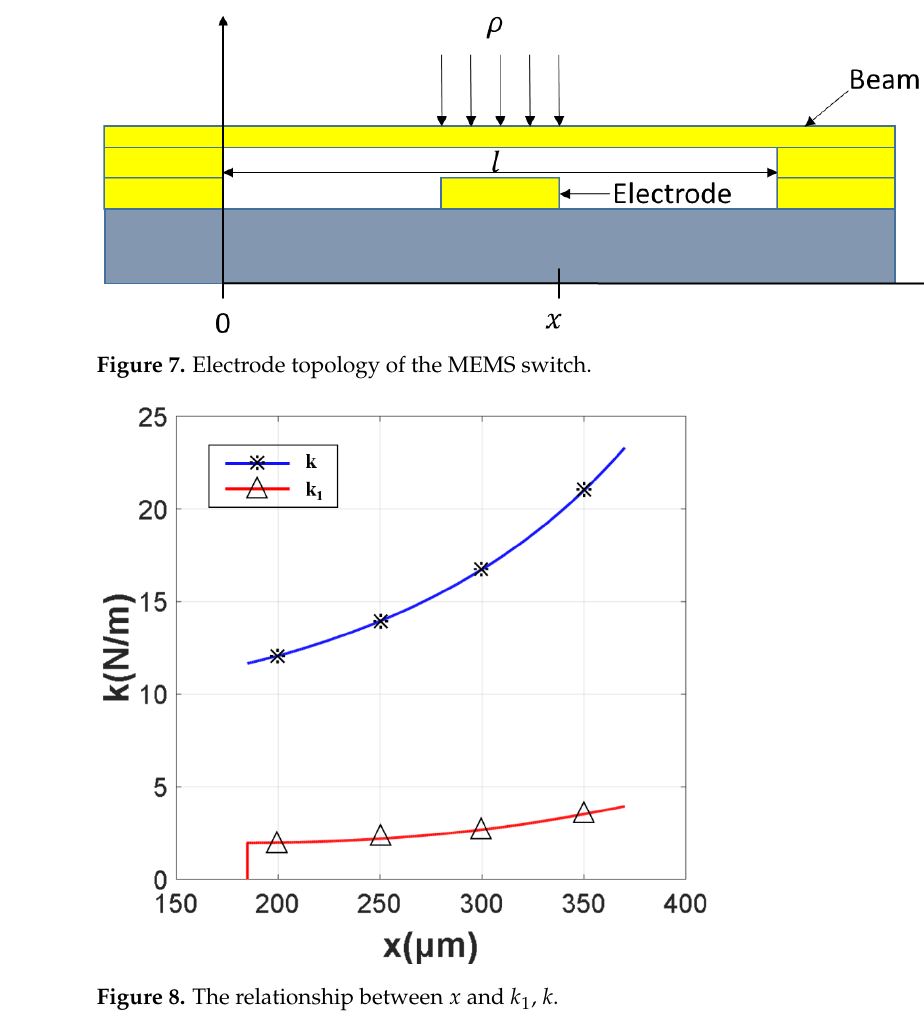
Figure 6. The relationship between the parameters of g , Cr and λ .